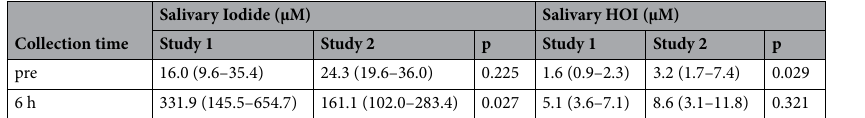
Table 1. Comparison of studies 1 and 2 in terms of salivary iodide and HOI levels before (pre) and 6 h after iodine contrast injection. Data are expressed as median (IQR), analyzed by Mann–Whitney test.